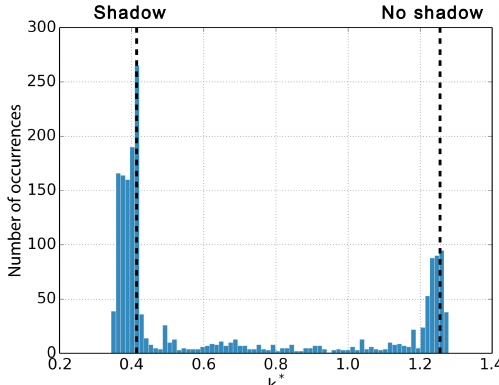
Figure 4. Histogram of measured clear sky indices k ∗ of the previ- ous 30min from one pyranometer station in order to determine k ∗ for shadow and no-shadow